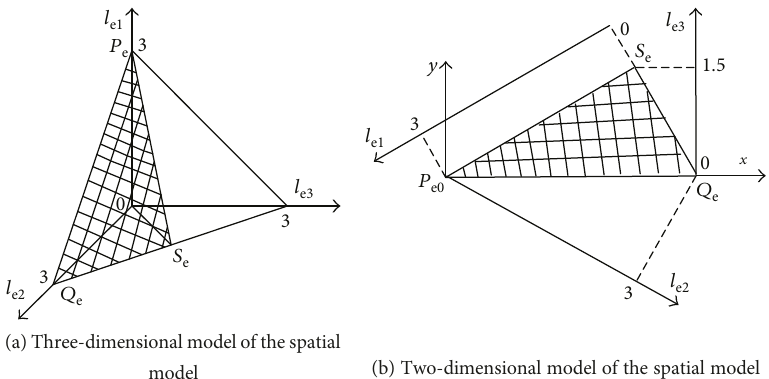
Figure 4: The spatial model of the biomimetic robotic elbow joint.